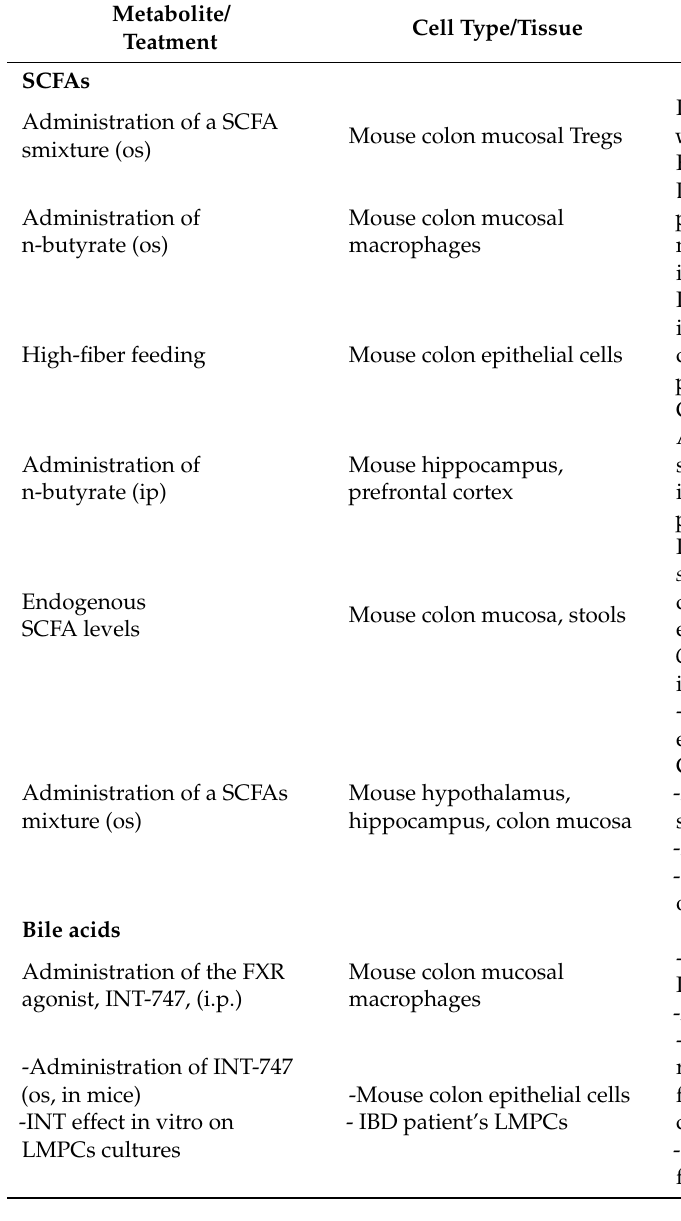
Table 2. Examples of cellular/tissue targets for microbial metabolites along the microbiota gut–brain axis involved in the intestinal inflammatory